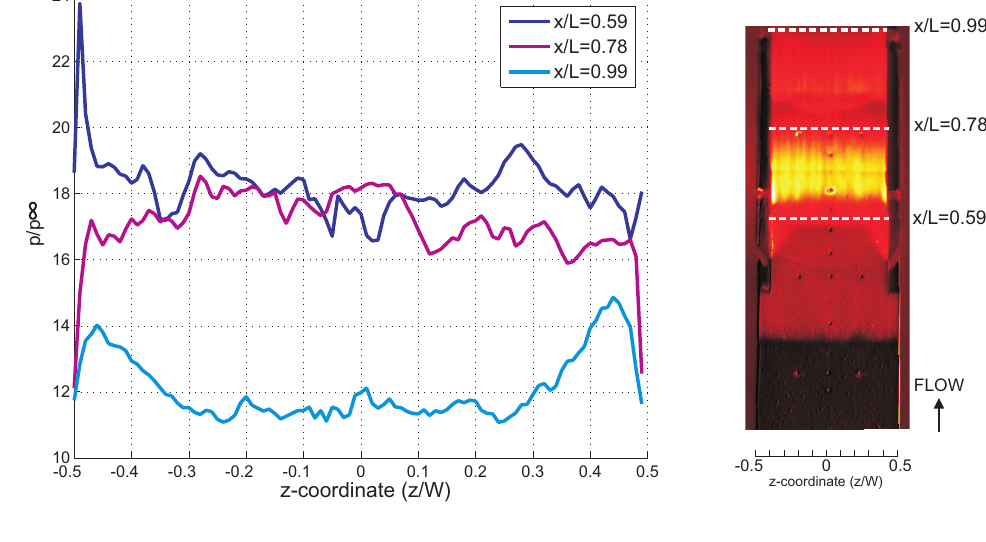
Figure 16. Normalized spanwise static pressure for the AoA-2 case taken at the isolator entrance x / L = 0.59, the middle of the isolator x / L = 0.78 and the isolator exit x / L =